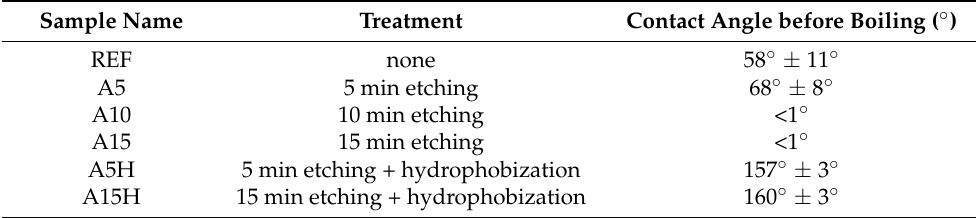
Table 1. Surface treatment and contact angles of samples used in the